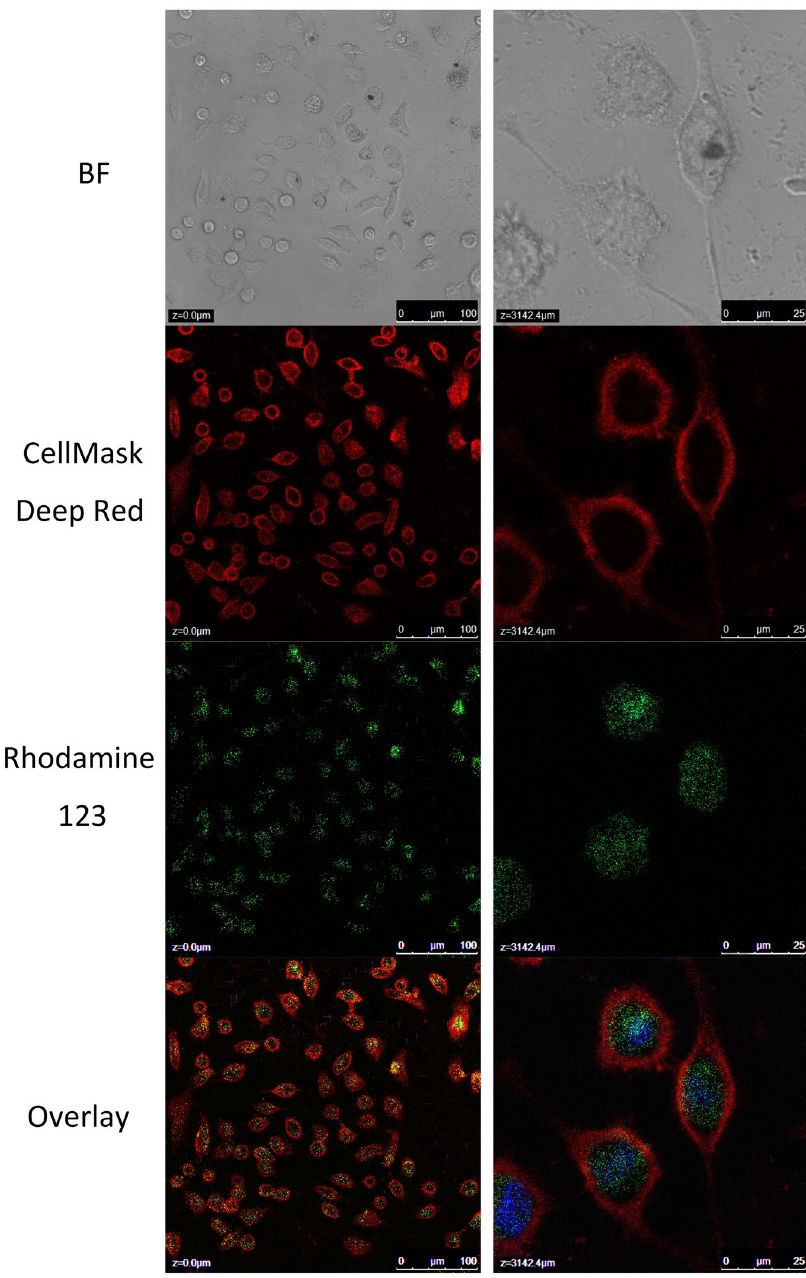
Figure 3. Confocal images of HepG2 cells with MWNTs-Met/PEG incubation (left) low magnification (right) high magnification. The nanotubes were found internalized and accumulated inside the cell about 3 hours after